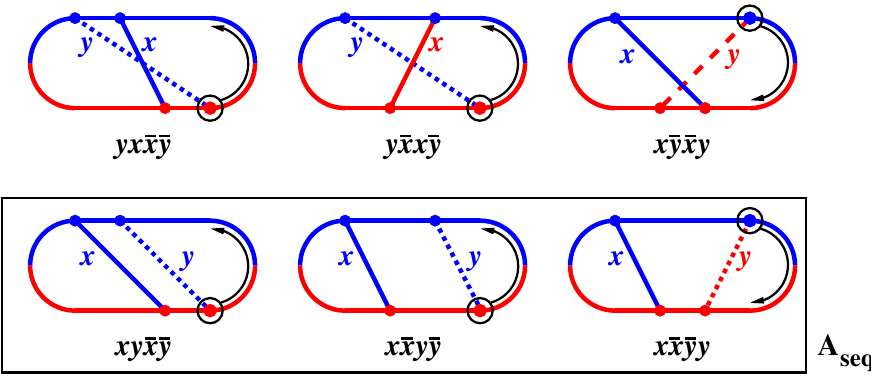
Figure 8 . The g → ggg diagrams corresponding to the ( x, y ) column of the upper darker-blue ( α ) rectangle of table 1. The black circles and arrows depict the action of a back-end transformation on these diagrams.